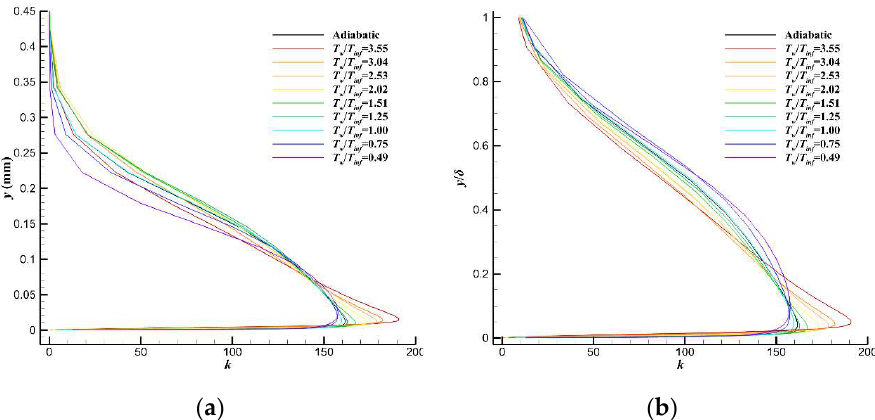
Figure 20. Temperature distributions of turbulent boundary layers. ( a ) T v.s. y ; ( b ) T v.s. y / δ.